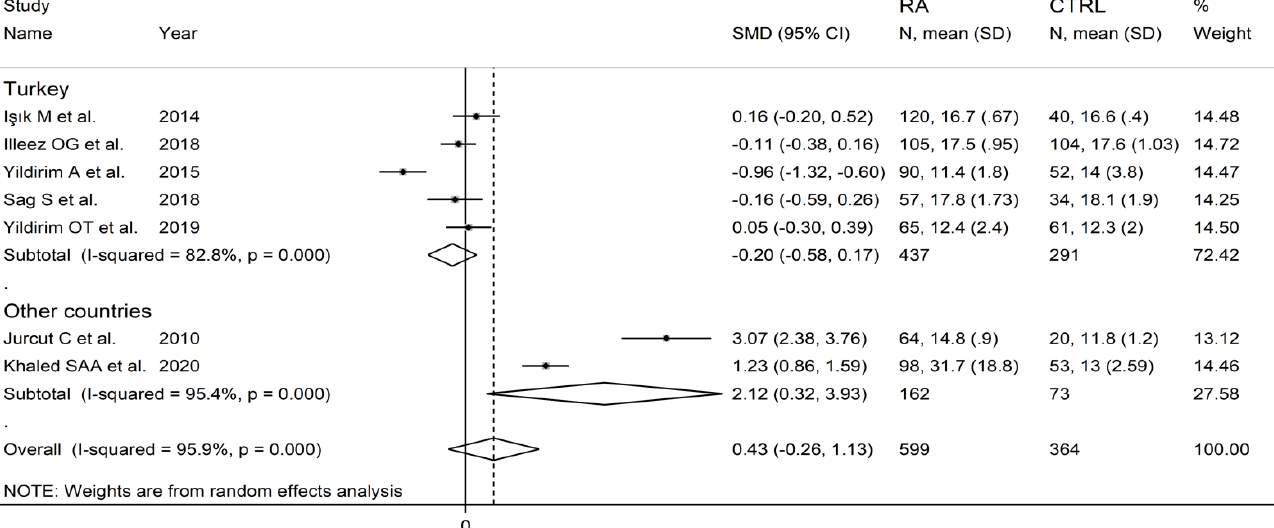
Figure 11. Forest plot of studies examining the platelet distribution width in patients with rheumatoid arthritis and healthy controls according to the country where the study was